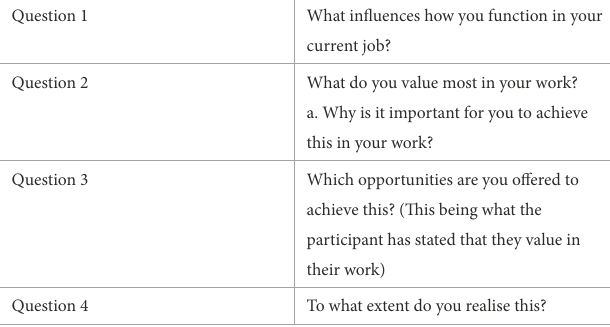
TABLE 1 Interview protocol for functioning of